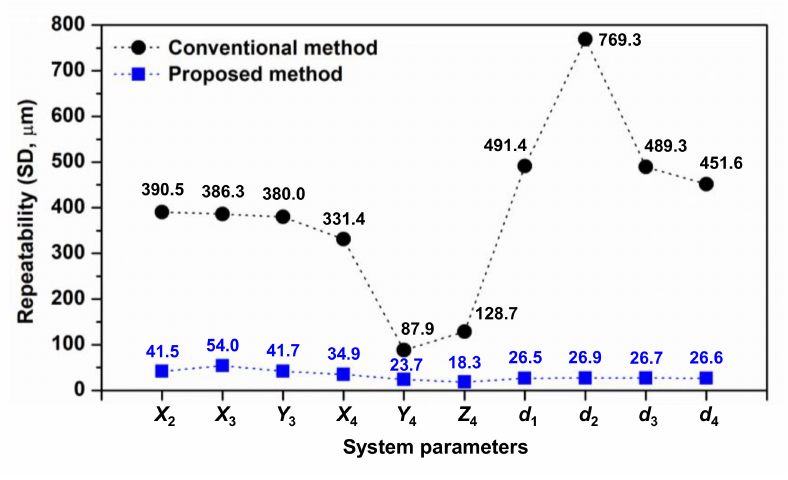
Figure 9. Estimation repeatability of system parameters using proposed and conventional self-calibration methods